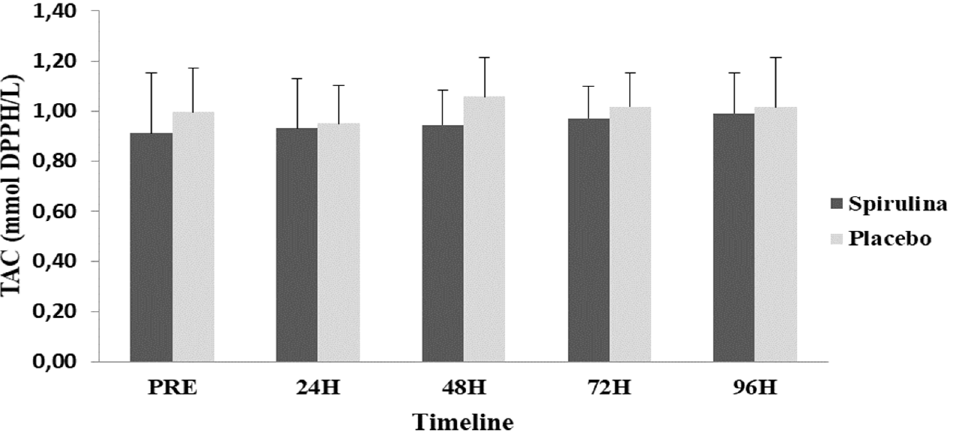
Figure 5. Change in total antioxidant capacity (TAC) concentration in response to eccentric protocol. PRE, Baseline measurement; H, Hours.